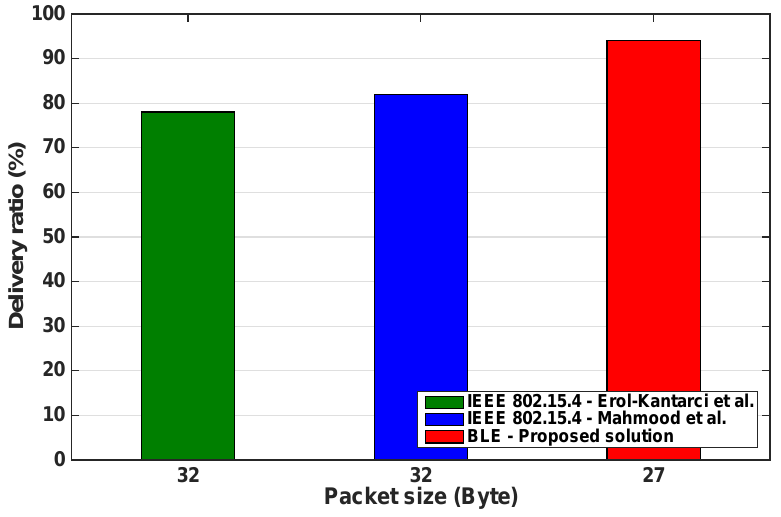
Figure 11. Delivery ratio of the wireless networks